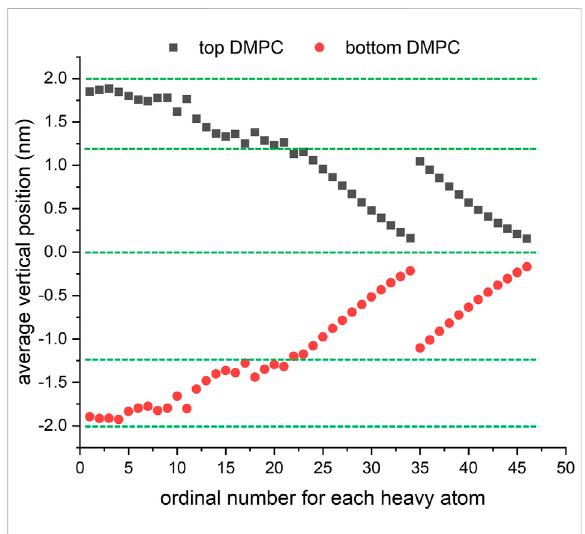
FIGURE 5 Average vertical position versus ordinal number for each heavy atom in the equilibrated DMPC